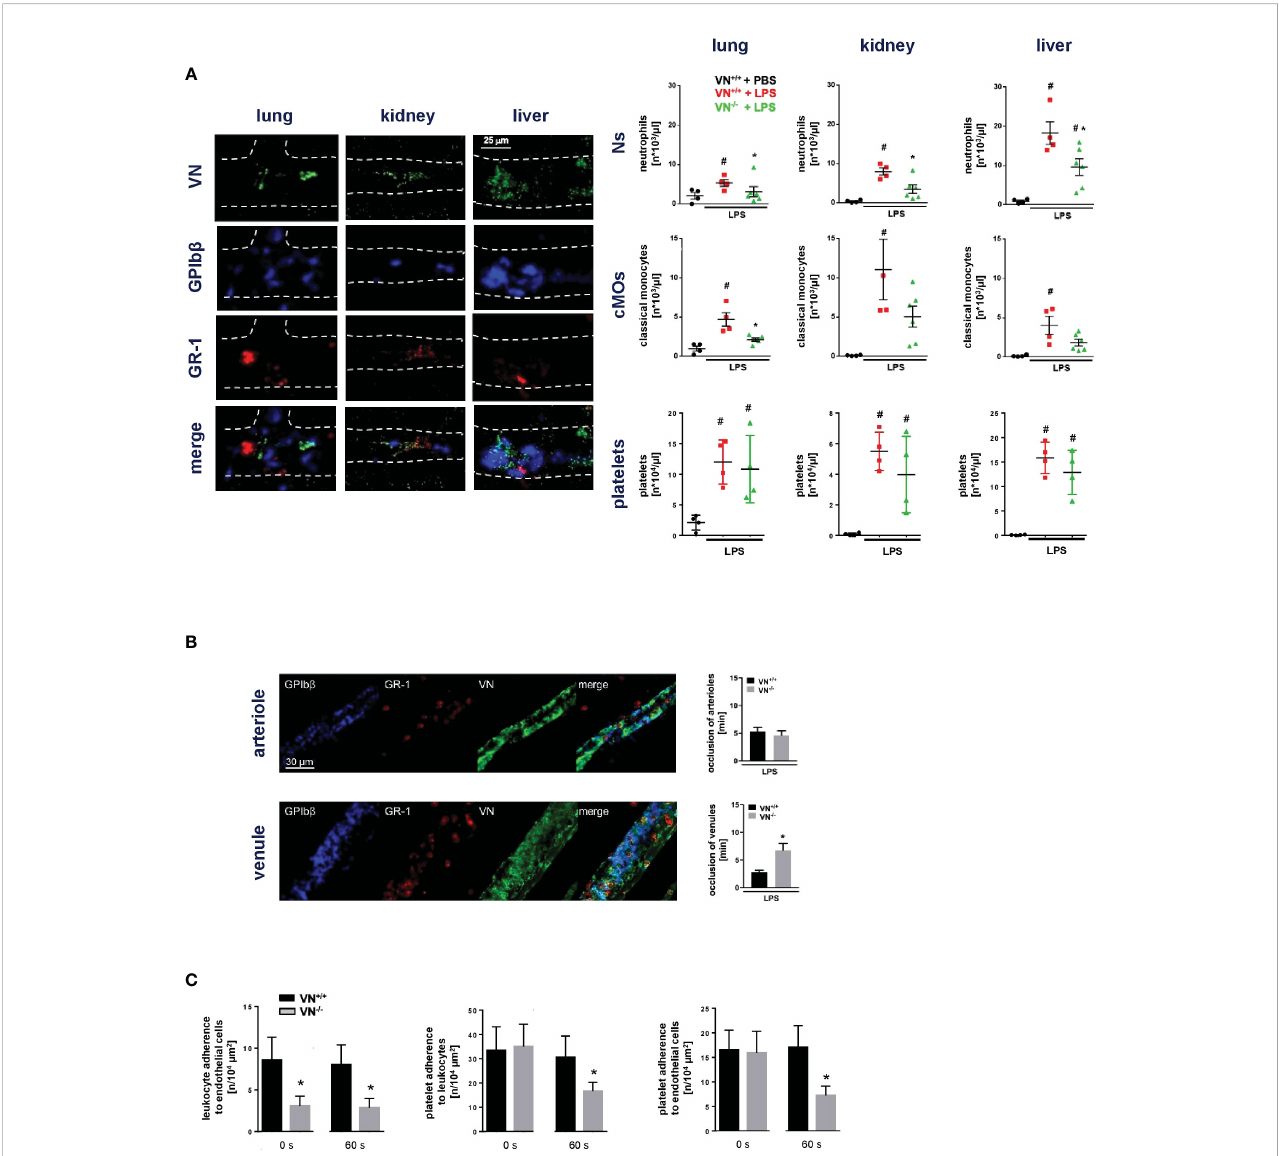
FIGURE 2 VN promotes microvascular immunothrombosis in systemic in fl ammation. (A) , left) Interactions of VN, GPIb b + platelets, and GR-1 + myeloid leukocytes in the hepatic, pulmonary, and renal microvasculature of WT mice treated with PBS or LPS as assessed by immunostaining and confocal microscopy, representative images are shown. (A) , right) Accumulation of neutrophils (Ns), classical monocytes (cMOs), and platelets (P) as assessed by fl ow cytometry in organ lysates from VN +/+ mice treated with PBS or LPS and VN -/- mice treated with LPS, quantitative data are shown (mean ± SEM for n=4-6 per group; #p<0.05 vs. VN +/+ +PBS; *p<0.05 vs. VN +/+ +LPS). (B) Photochemical injury-elicited venular and arteriolar thrombus formation in the LPS-stimulated cremaster muscle of VN +/+ or VN -/- mice as assessed by multi-channel in vivo microscopy, quantitative data for occlusion times as well as (C) for interactions of single platelets, myeloid leukocytes, and venular endothelial cells prior to induction of (0 s) or 60 s after induction of photochemical injury-elicited thrombosis are shown (mean ± SEM for n=4-6 per group; *p<0.05 vs. VN +/+